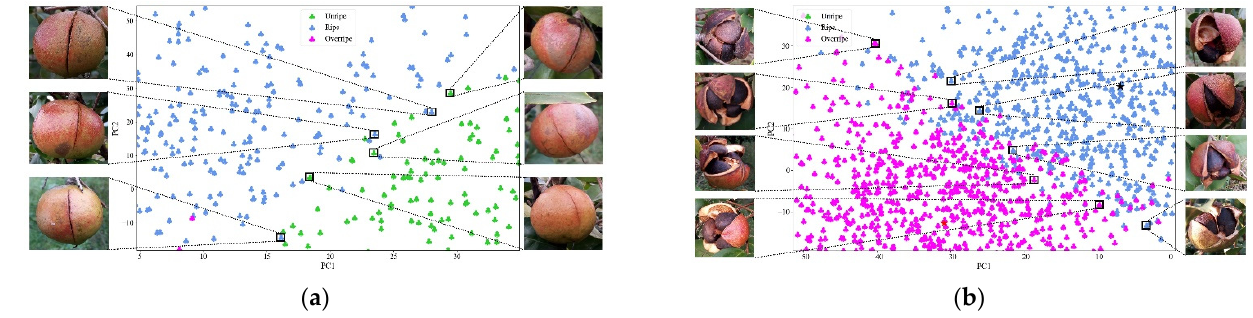
Figure 5. The distribution of Camellia oleifera fruits in the overlapping regions and the example images located in overlapping regions: ( a ) the distribution of Camellia oleifera fruit images in unripe and ripe overlap regions and the example images located in overlapping regions, and ( b ) the distribution of Camellia oleifera fruit images in ripe and overripe overlap regions and the example images located in overlapping regions.